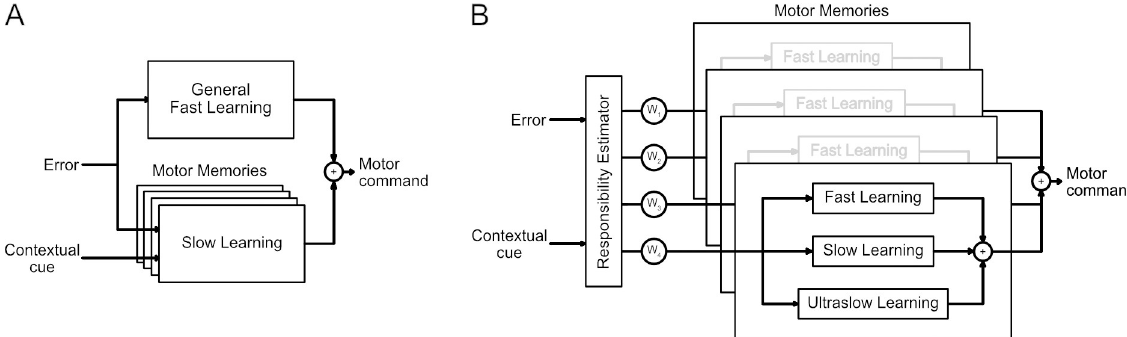
Fig 12. Models of motor learning. A. The dual-rate model with multiple slow processes acting in parallel and a single general fast process as proposed previously [24]. B. Our proposed model of adaptation consists of multiple parallel motor memories, each involving a fast, slow and ultraslow process, all weighted by a responsibility